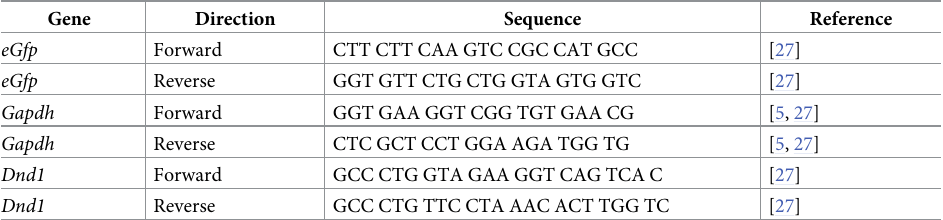
Table 4. RT-qPCR